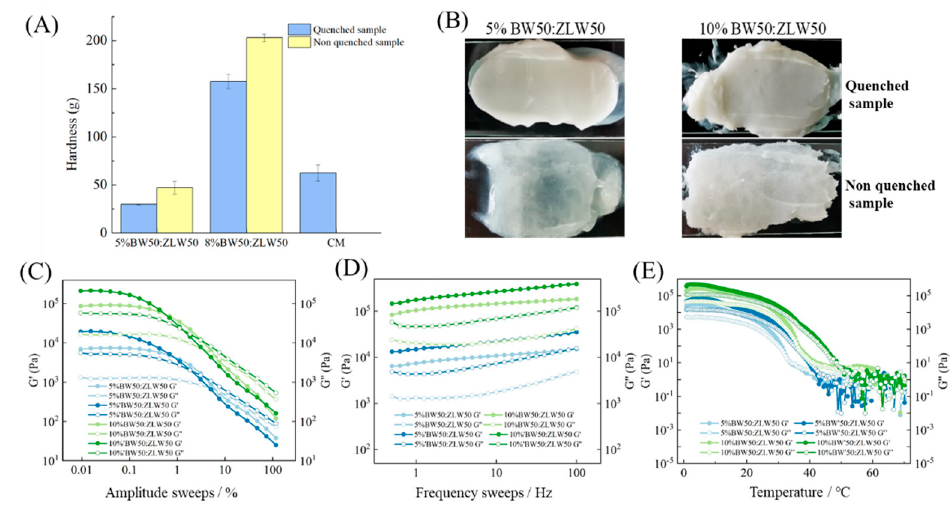
Figure 5. Hardness ( A ), smear appearance ( B ), amplitude sweeps ( C ), frequency sweeps ( D ), and temperature ramps ( E ) of binary wax-based margarine, respectively.